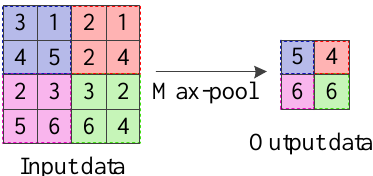
Figure 4. A simple example of the maximum pooling operation.